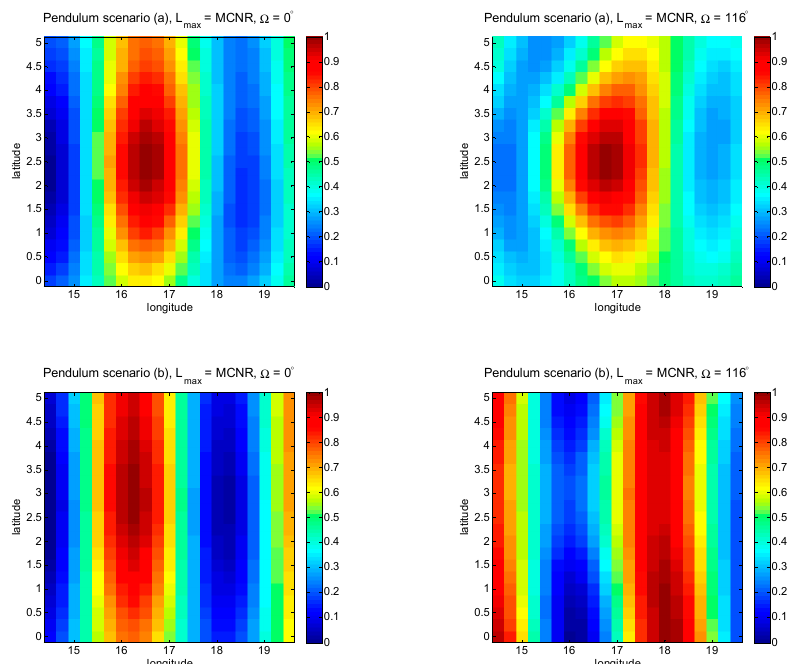
Figure 28. Spatial covariance of a selected point in West Africa (from Figures 19 and 20) for 6-day solution of the Pendulum formation up to L max = MCNR, for top : scenario (a), and bottom : scenario (b). Left is Ω = 0 ◦ and right is Ω = 116 ◦